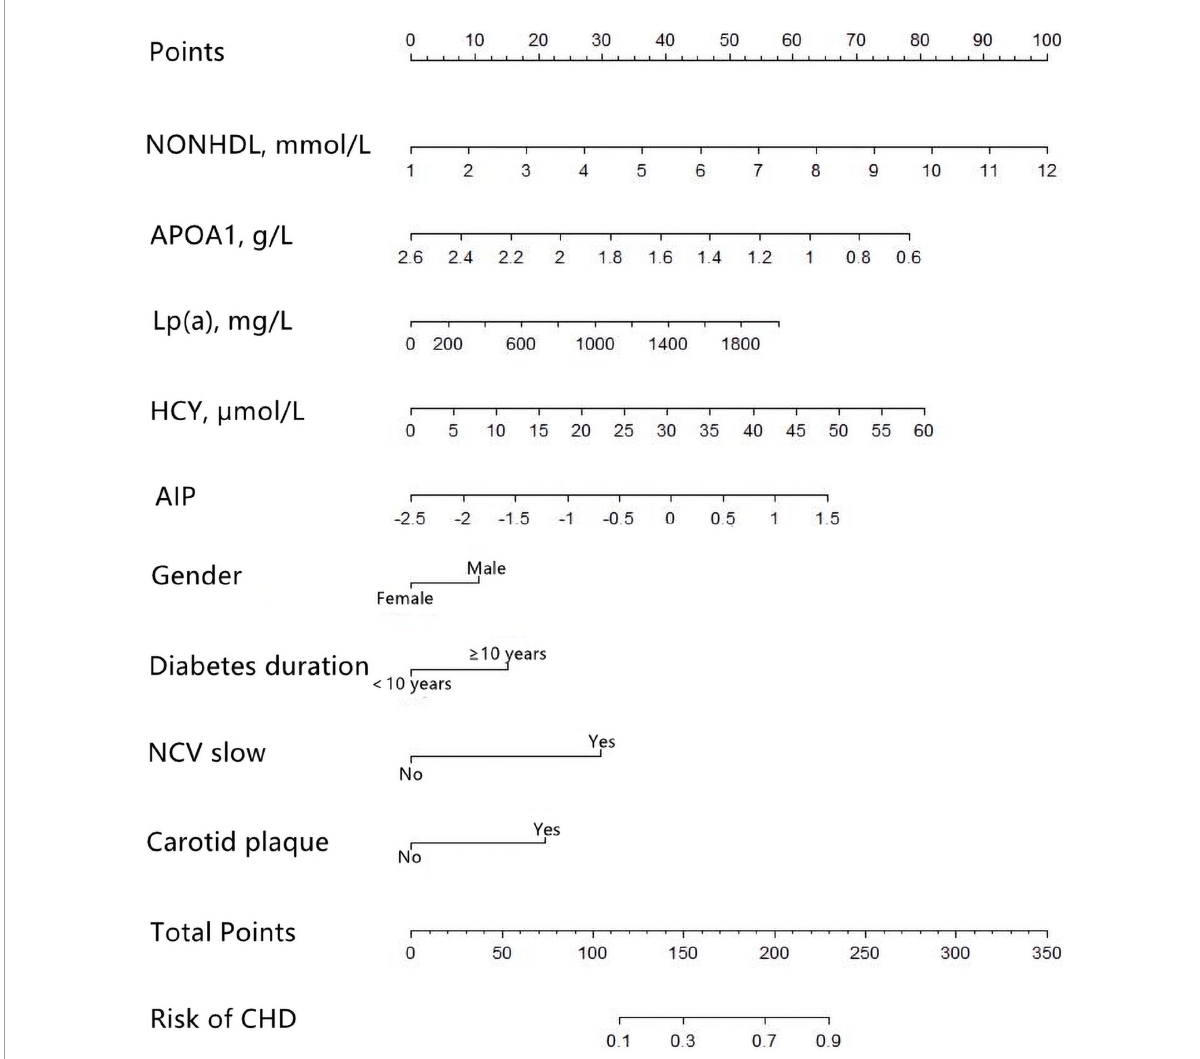
FIGURE2 Development of the coronary heart disease (CHD) prediction nomogram. The CHD prediction nomogram was developed in the training cohort, with Gender, Duration, non-high-density lipoprotein cholesterol (non-HDL-C), apolipoprotein A1 (APOA1), lipoprotein-a [Lp(a)], homocysteine (HCY), atherogenic index of plasma (AIP), nerve conduction velocity (NCV), and Carotid plaque as